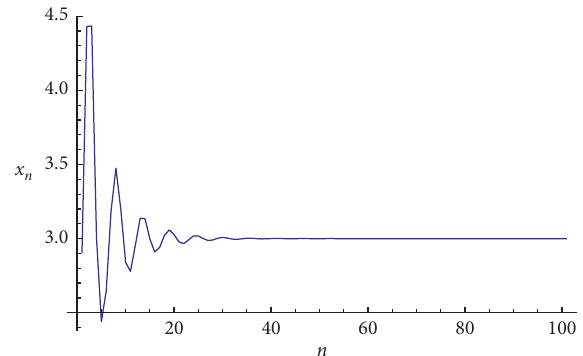
Figure 2: Phase portrait of equation (8) with x